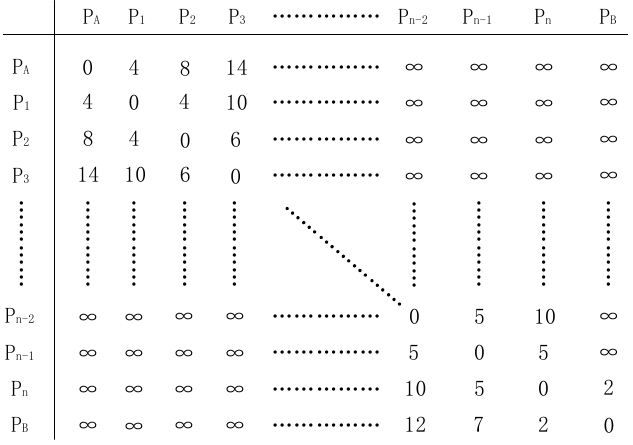
Figure 10. Topology matrix of prefabricated component hoisting route planning. Table 1. Effect analysis table of hoisting route planning for a prefabricated floor.